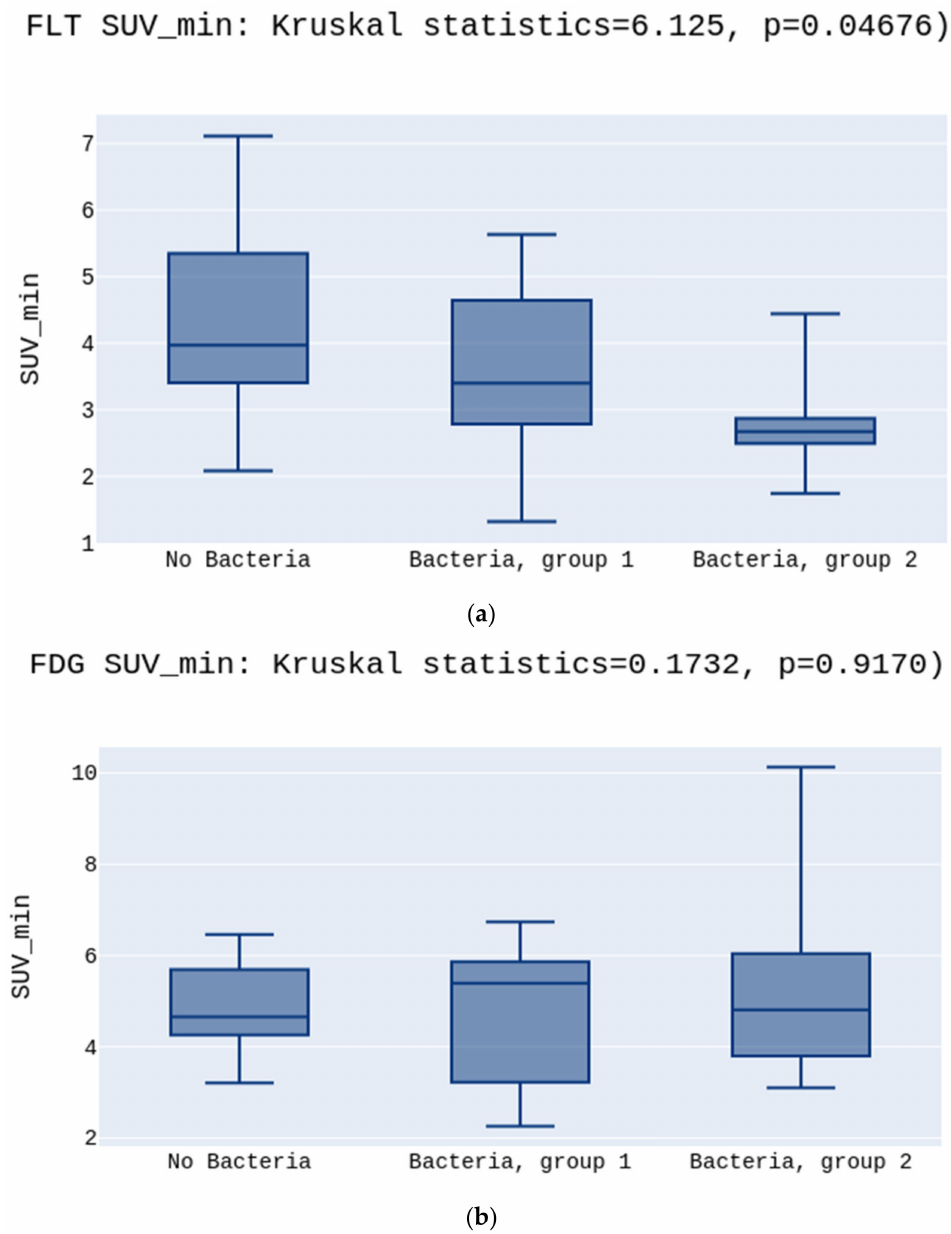
Figure 3. ( a ) presents the highest SUV min in the No Bacteria Group, followed by Group 1, and the lowest in Group 2 for the [ 18 F]FLT, p = 0.03. ( b ) presents no differences between SUV min in the No Bacteria Group, Group 1, and Group 2 for the [ 18 F]FDG, p > 0.05. Comparing the uptake of [ 18 F]FLT between the two groups No bacteria vs. presence of Bacteria (Bacteria group) there was a significant difference in SUVmax values (9.2 vs. 6.4, p = 0.043, respectively) (Figure